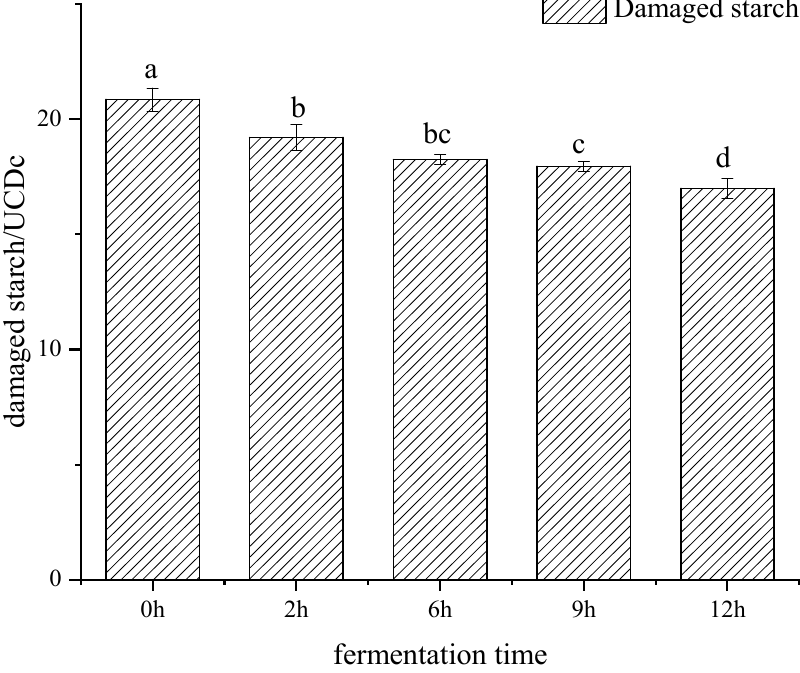
Figure 1. Damaged starch content of starch separated from bifidobacteria-fermented dough under different fermentation times. The representation of different letters have significant difference ( p < 0.05).